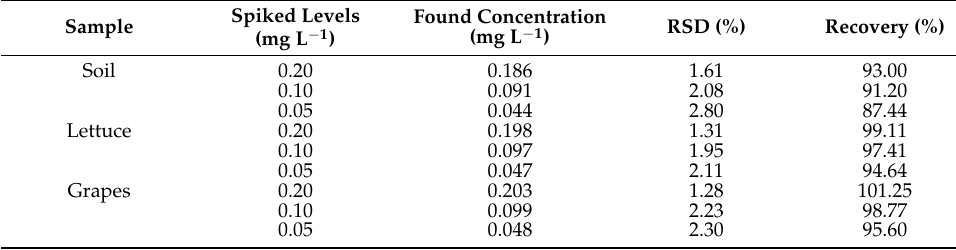
Table 3. Determination of fenthion in real